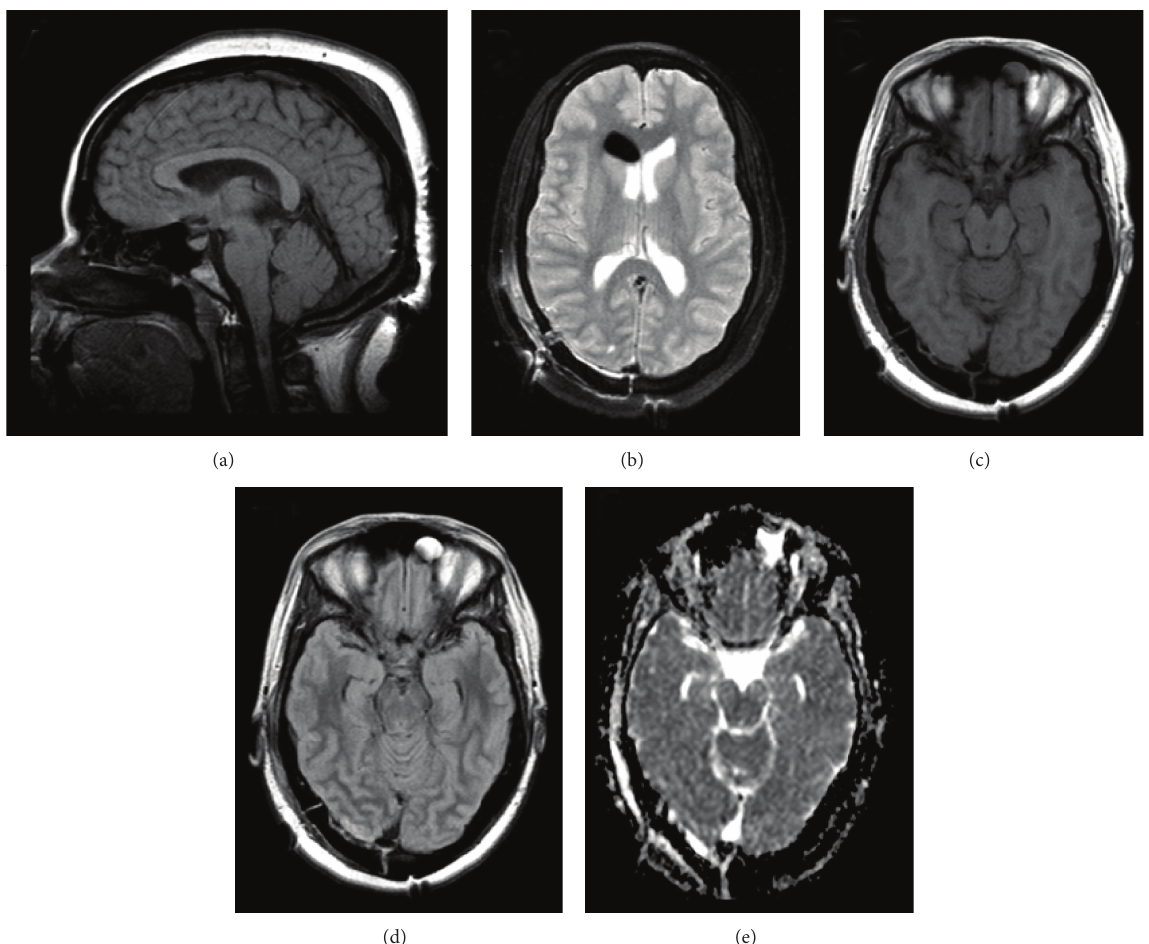
Figure 3: Postoperative MRI obtained within 24 hours after surgery. The midsagittal T1-weighted image shows complete resection of pineal cyst with reexpansion of the tectum (a). There is significantly reduced pneumocephalus in the subarachnoid space, but ventricular air is still present (b). Of note, there is no hemorrhage on T1 (c), edema on FLAIR (d), or ischemic changes on diffusion restriction images (e) in the vicinity of the oculomotor nuclei in the dorsal midbrain or oculomotor nerves in the ventral